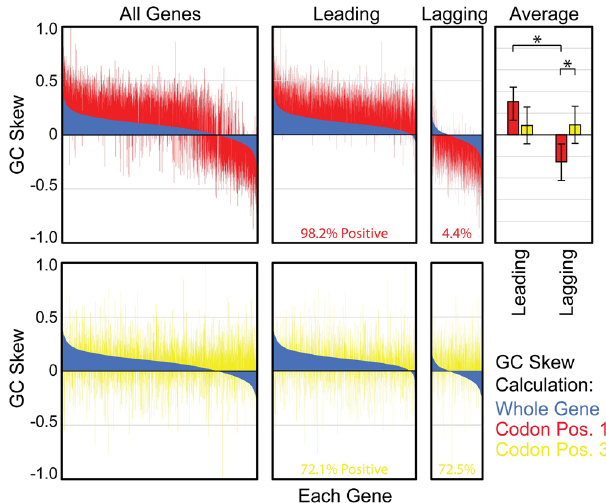
Fig. 2 GC Skew values for whole-gene regions. Upper graphs: GC skew values are calculated using whole-gene regions (blue) or only codon position 1 nucleotides (red) for all B. subtilis genes, leading strand genes only (Leading), or lagging-strand genes only (Lagging). Genes are sorted based upon the whole-gene GC skew resulting in the appearance of a curve. CP1 and CP3-based values are not independently sorted, allowing for direct comparison between data sets. The average GC skew values (Average) demonstrate that CP1-based GC skew values (red) are signi fi cantly different for leading versus lagging-strand genes, whereas CP3-based values (gold) are not. Additionally, CP1-based GC skew values are signi fi cantly different from CP3-based values for lagging-strand genes. Error bars represent the standard error of the mean. Signi fi cance was determined by the z-test, asterisk symbol (*) indicates p = 0.0. The percentage of positive CP1-based GC skew values is shown at the bottom of the Leading and Lagging-strand gene graphs. Lower graphs: Whole-gene (Blue, same data as upper graphs) versus CP3-based GC skew values are